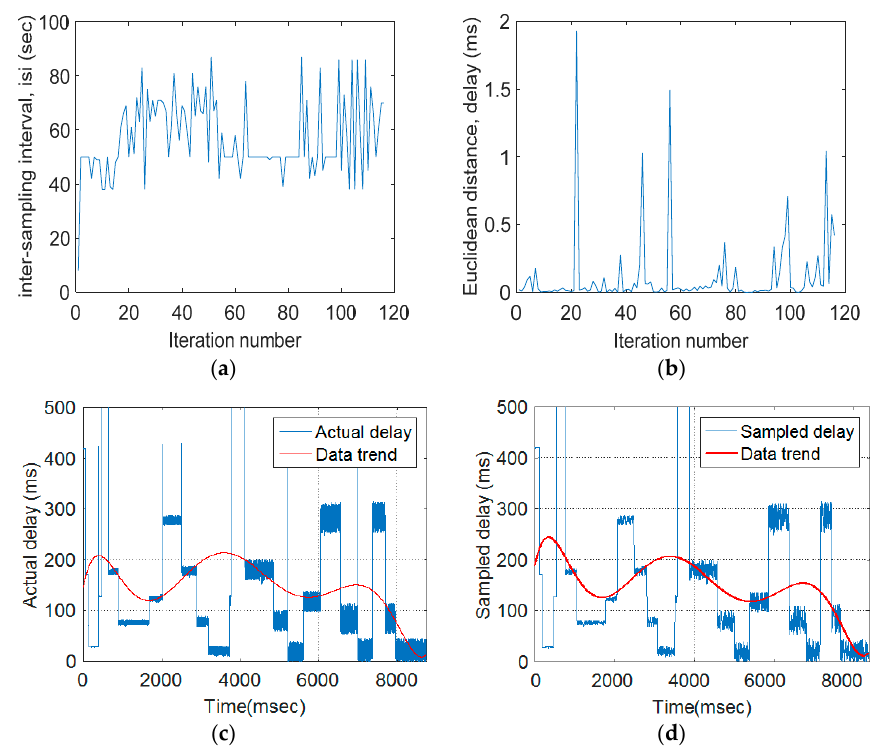
Figure 8. Typical results obtained from the developed adaptive technique: ( a ) FIS output for the inter-sampling interval ( isi ), ( b ) the Euclidean distance for delay, ( c ) original traffic delay, and ( d ) sampled traffic delay.